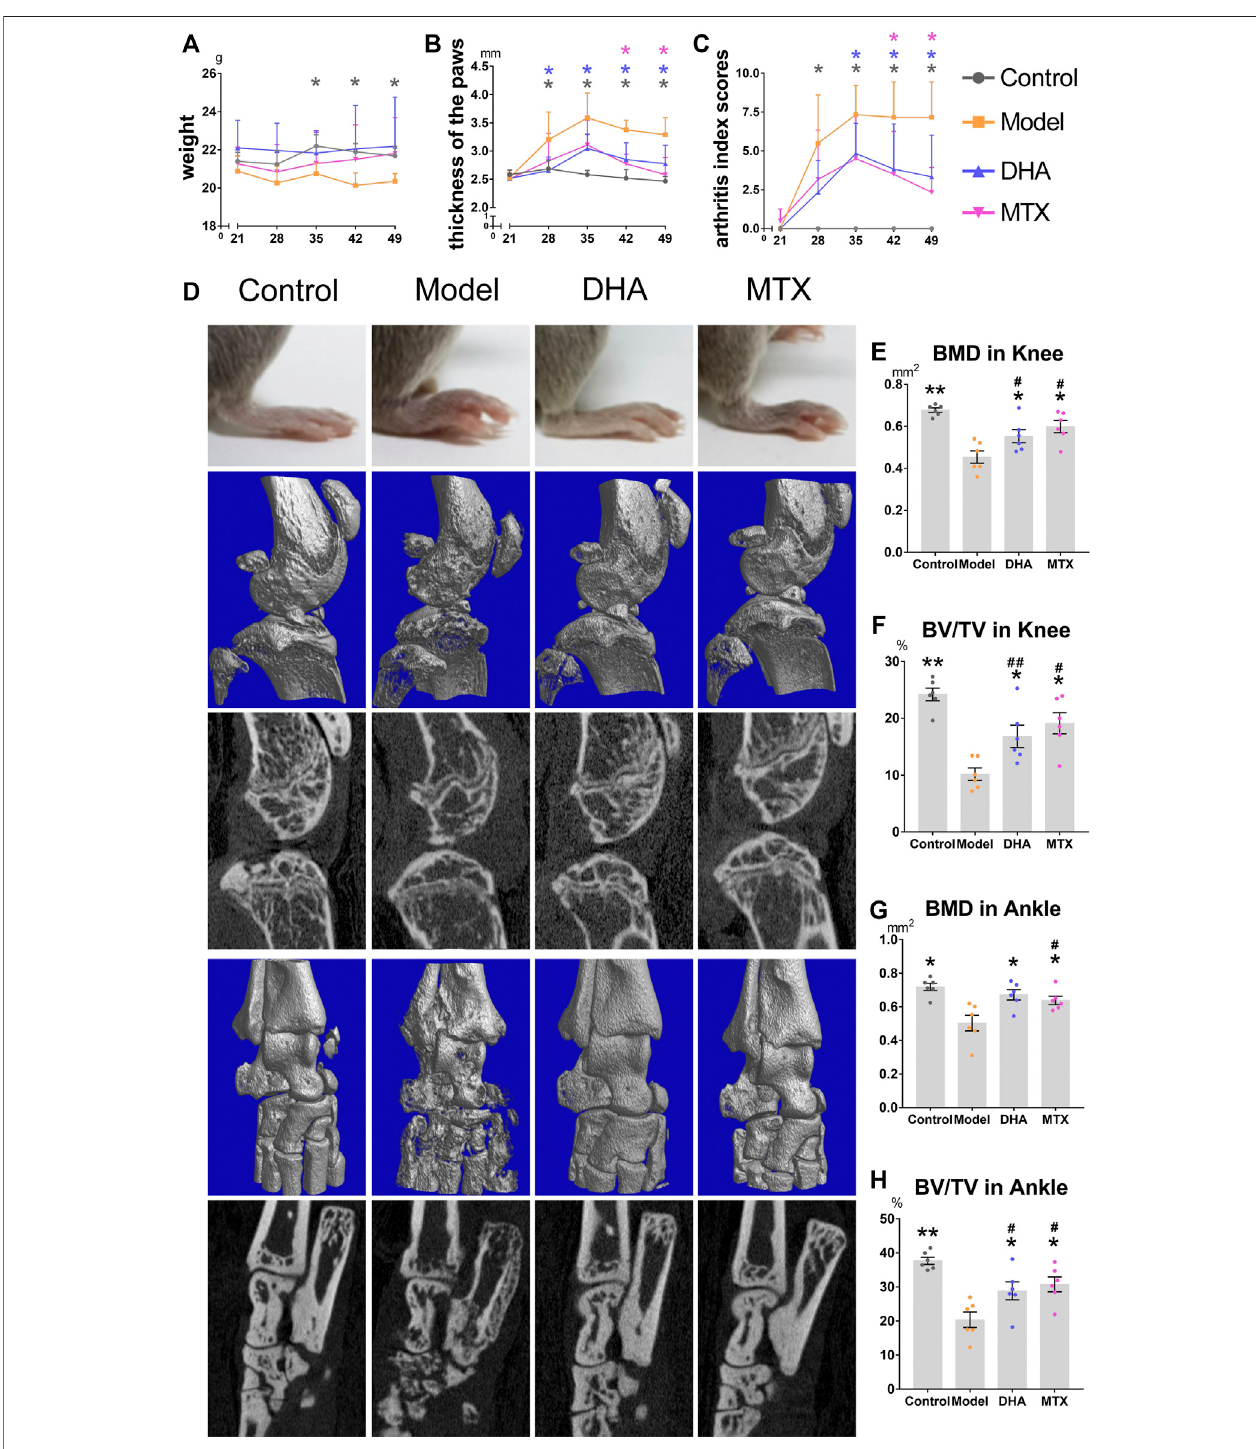
FIGURE1 | DHA alleviated in fl ammationand jointdestruction inCIA mice. (A) Body weight were recorded weekly during the experiment. (B) The thickness ofhind pawswasmeasuredweeklybydigitalcalipers. (C) Arthritisindexscorewasusedtoscoreeachmiceeveryweek,withthehighestscoreof16. (D) Imagesofswollenhind paws of mice. The right hind ankle and knee of mice were scanned by the Skyscan 1176 Micro-CT Imaging System. (E – H) The BV/TV and BMD in knee and ankle were calculated. * p < 0.05, ** p < 0.01 vs. the model group. # p < 0.05, ## p < 0.01 vs. the control group.